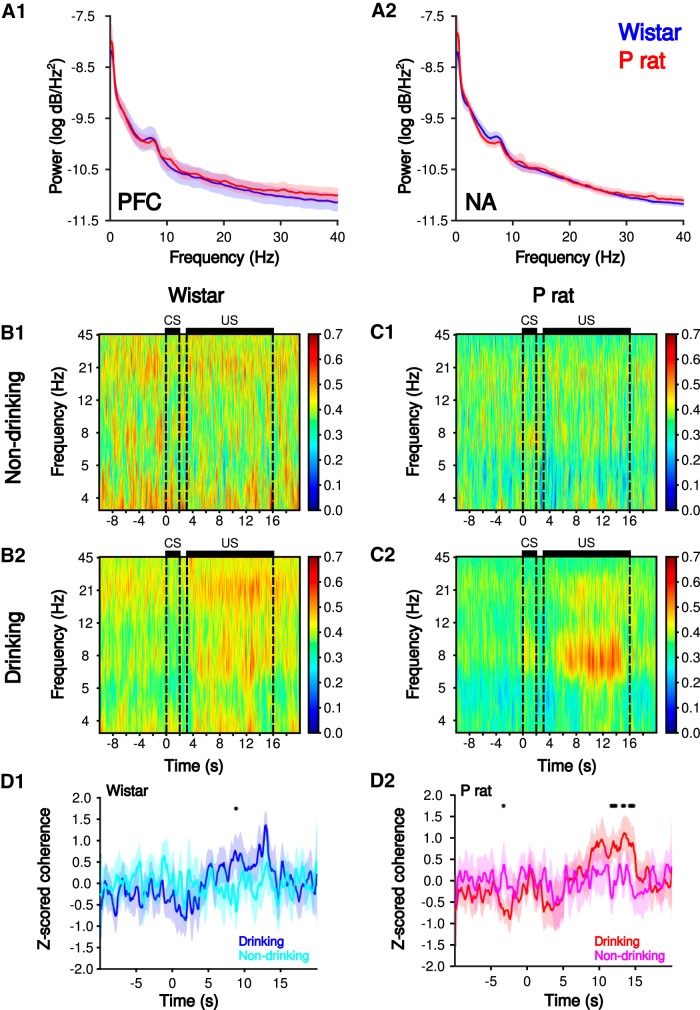
Theta oscillation are present in the 2CAP and are associated with drinking behaviors. Power spectral densities (A) in the mPFC (1) and NA (2) show a prominent peak in the θ frequency. Mean traces of mPFC-NA spectral coherence during non-drinking (1) and drinking (2) trials in Wistars (B) and P rats (C). Theta band wavelet coherence between the mPFC and NA for non-drinking (cyan, pink) and drinking (blue, red) trials in Wistars (D1) and P rats (D2); *p < 0.05 Bonferroni post hoc, drinking versus non-drinking.